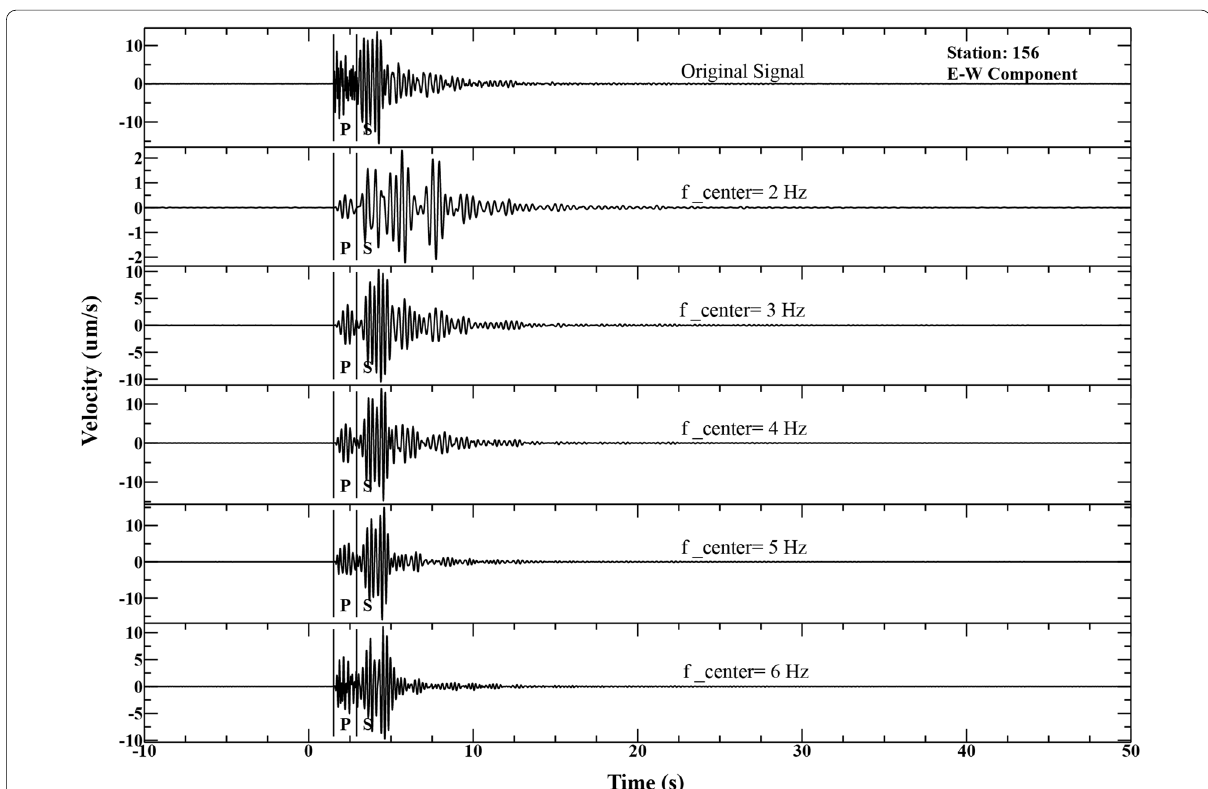
Fig. 6 Traces of the original signal and the filtered waveforms at five center frequencies. The vertical axis shows the velocity in um/s and horizontal axis indicates time in s